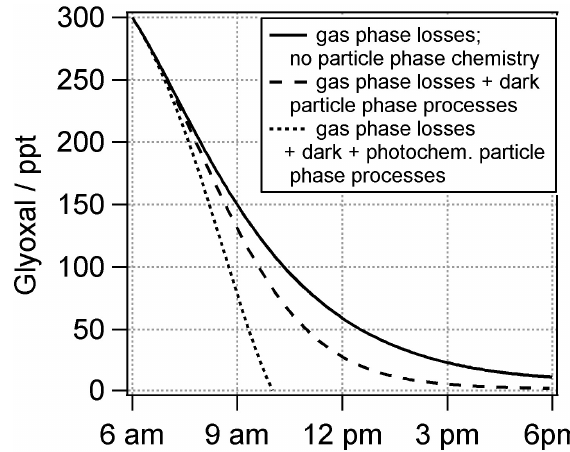
Fig. 8. Concentration profile of glyoxal in the gas phase as a func- tion of time depending on chemical mechanism used (with and without (photochemical) particle phase reactions,